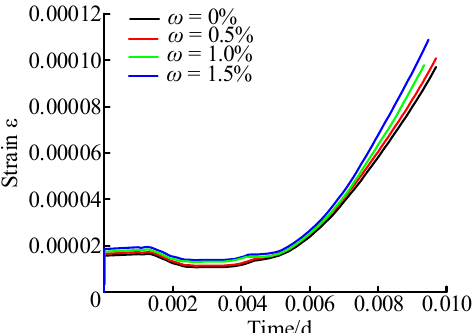
Figure 7. Instantaneous elastic deformation stage when the axial stress is 5 MPa.